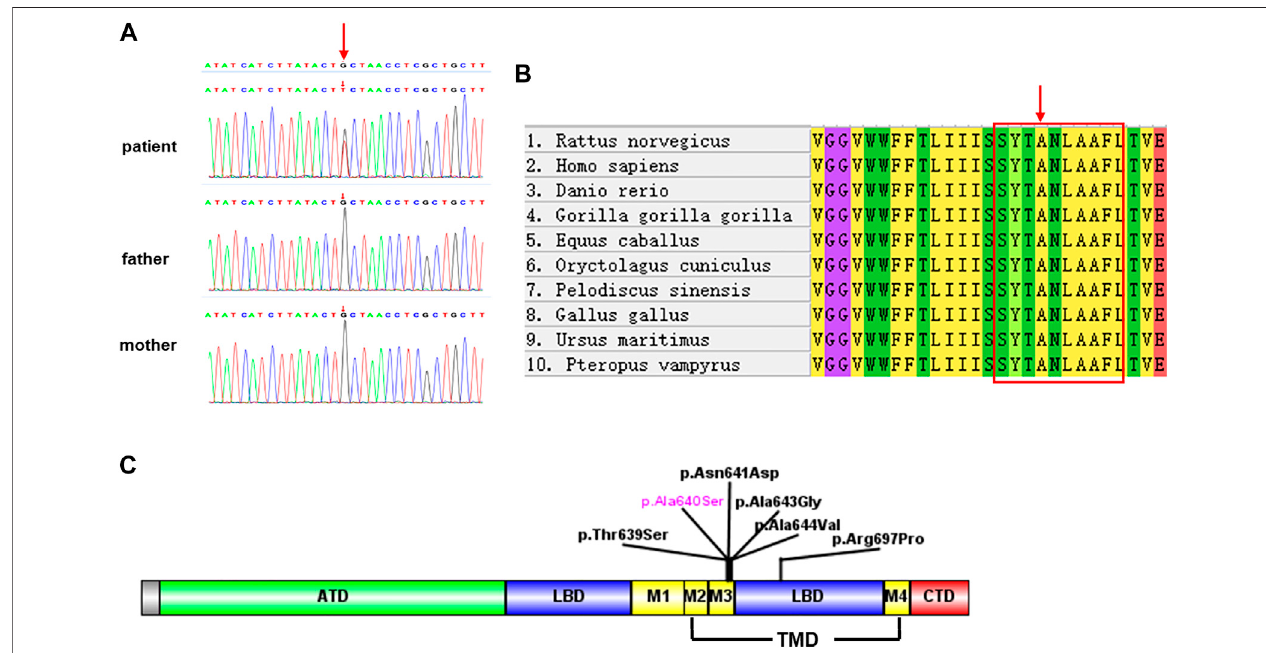
FIGURE2|(A) Sangersequencing validationofthevariantc.1918G > Tintheproband and parents. (B) Multiplespecies sequence alignment.Themutatedalanine A640 (red arrow) falls within a highly conserved SYTANLAAF motif (red box). (C) Schematics depicting the location of GRIA4 variants. Amino-terminal domain (ATD, in